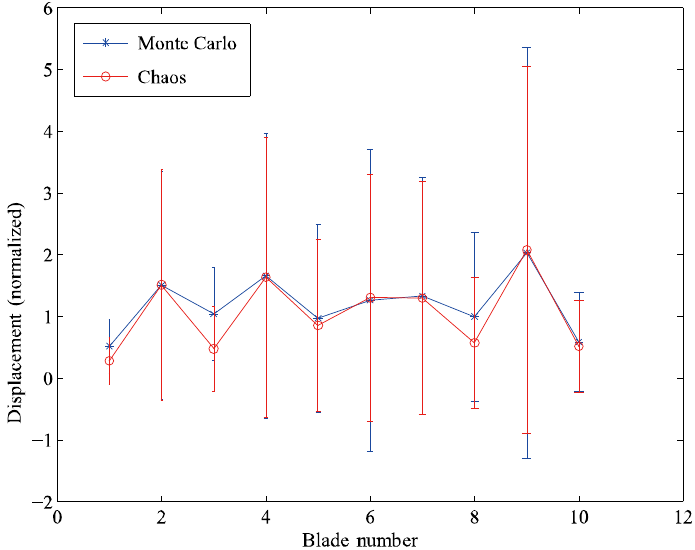
Fig. 8. Displacement at mid-span on the trailing edge. Mean and deviation at  for Monte-Carlo and chaos, for a standard deviation of